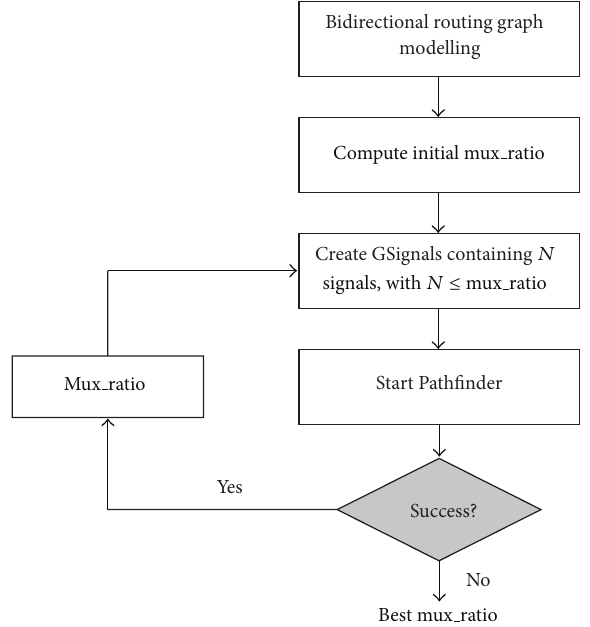
Figure 9: Routing flow on bidirectional